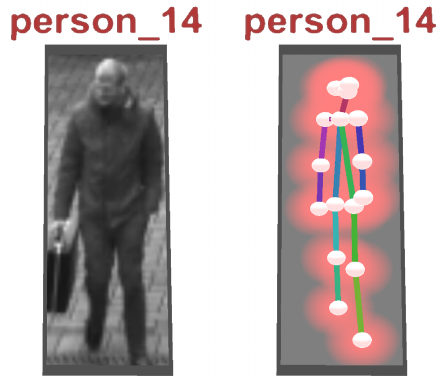
Figure 9. For each person recognized in a video frame ( Left ), OpenPose is applied for skeleton extraction. The extracted skeletons can later be displayed in the scene as connected points ( right